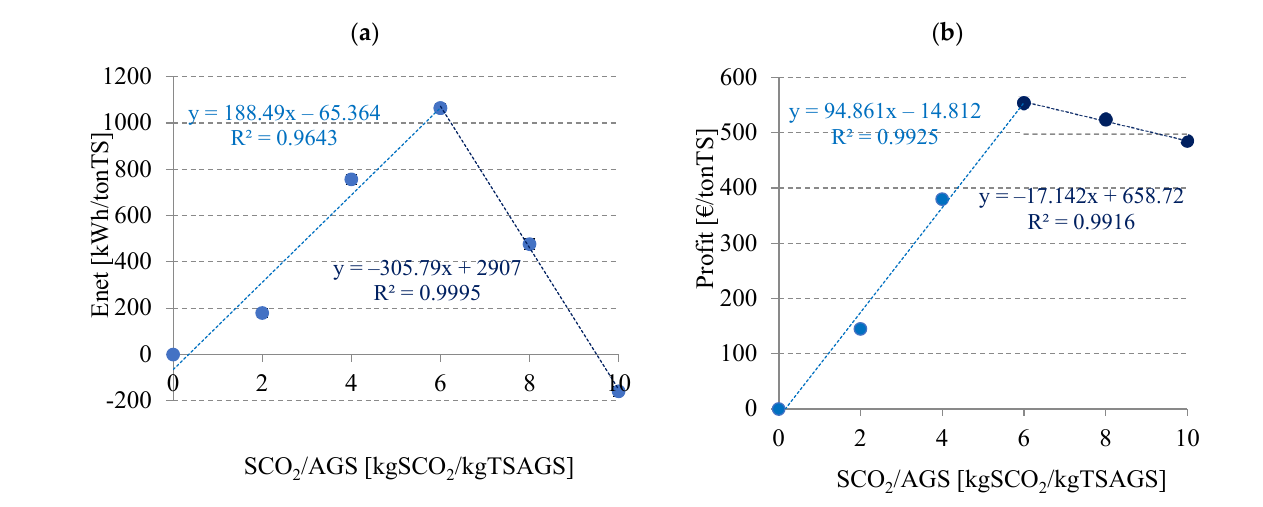
Figure 10. Correlations between the SCO 2 /AGS mass ratio and ( a ) Enet, and ( b ) Profit. Table 6. Estimated economic